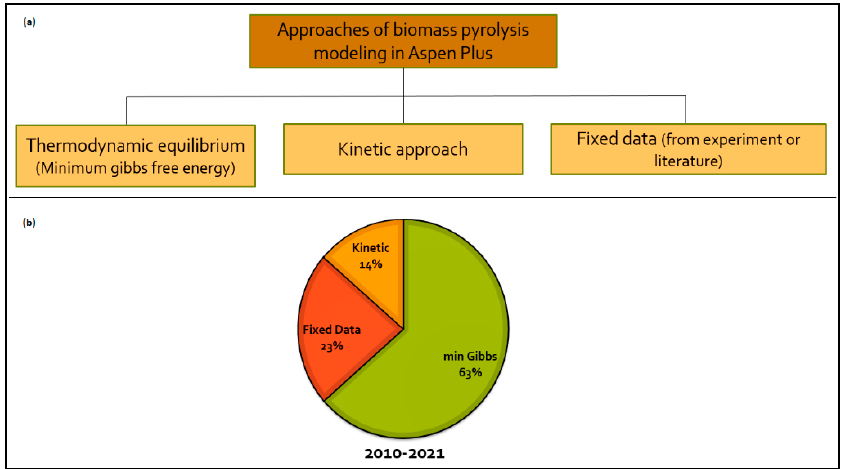
Figure 2. A categorization of biomass pyrolysis modeling types by Aspen Plus, ( a ): categorization of Aspen Plus biomass pyrolysis modeling approaches, ( b ): contribution of Aspen Plus biomass pyrolysis modeling approaches in the literature